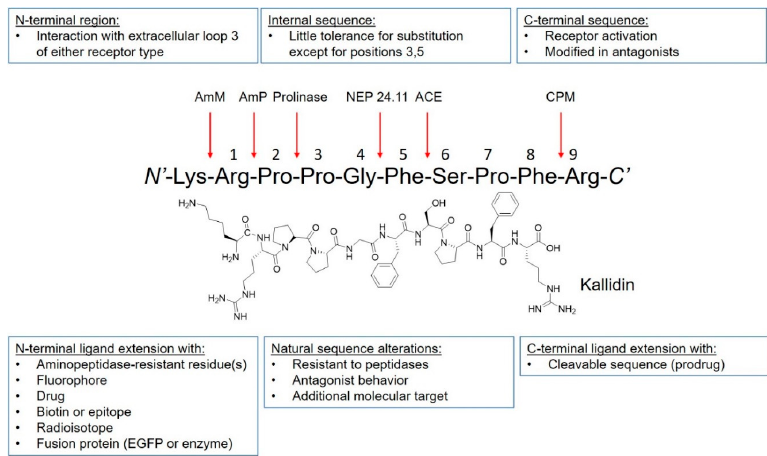
Figure 2. Peptide plasticity of kinins. Kinin peptides can be modified to improve bradykinin B1R or bradykinin B2R selectivity, increase resistance to enzymatic cleavage, confer agonistic or antagonistic properties, and prolong pharmacologic e ff ect. Moreover, peptide ligands can be conjugated to fluorophores, drugs, radioisotope complex, and be fused with other proteins. Arrows indicate positions of potential cleavage. AmM: aminopeptidase M; AmP: aminopeptidase P; NEP 24.11: neutral endopeptidase 24.11; ACE: angiotensin-converting enzyme; CPM: carboxypeptidase M. Figure adapted from Marceau, F., et al.